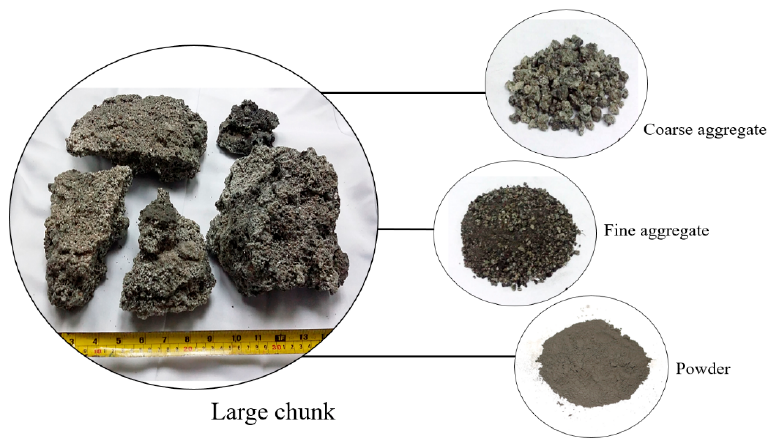
Figure 4. Palm oil clinker (POC).